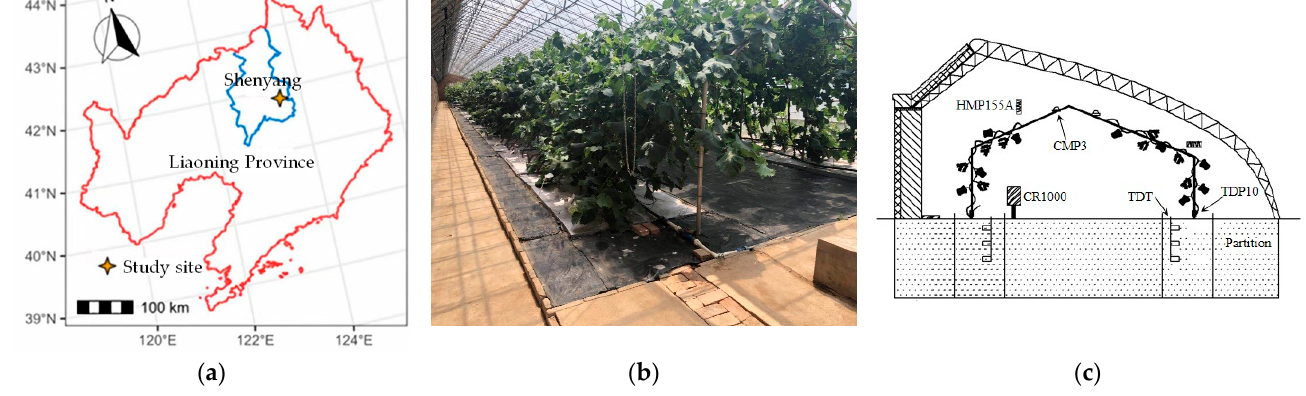
Figure 1. Experimental planting area of drip irrigation under plastic film and sensor layout. ( a ) Study site; ( b ) experimental planting area of drip irrigation under plastic film; ( c ) greenhouse structure and sensor layout. Table 1. Growth period division and transpiration in 2020 and 2021.